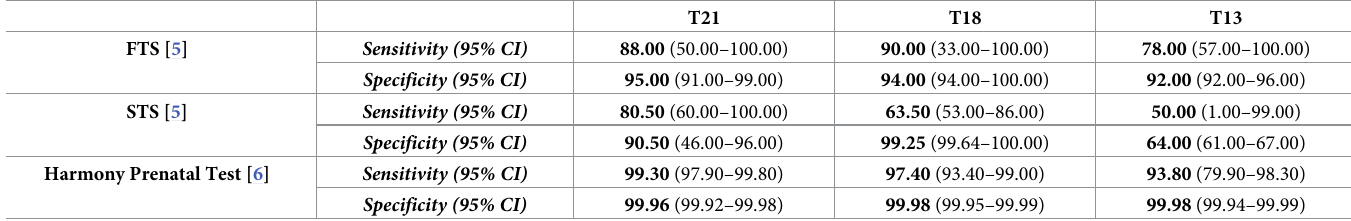
Table 1. SoC and harmony prenatal test